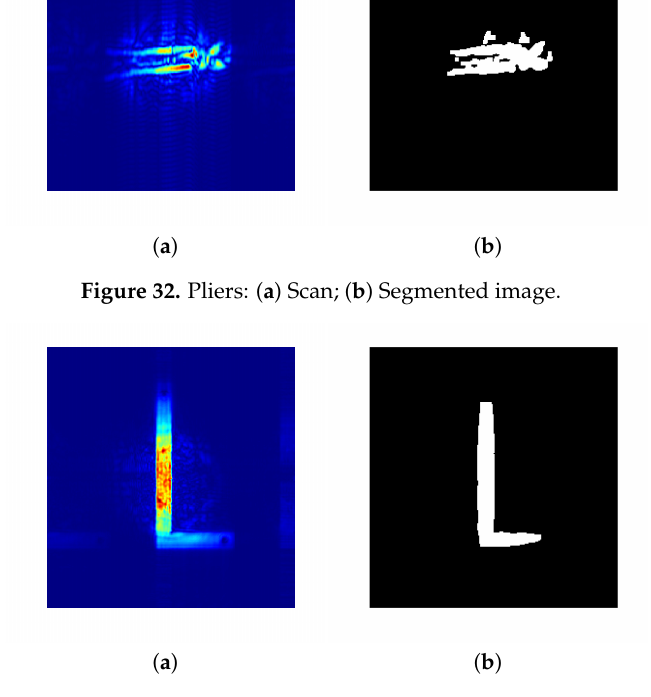
Figure 33. Bracket: ( a ) Scan; ( b ) Segmented image.